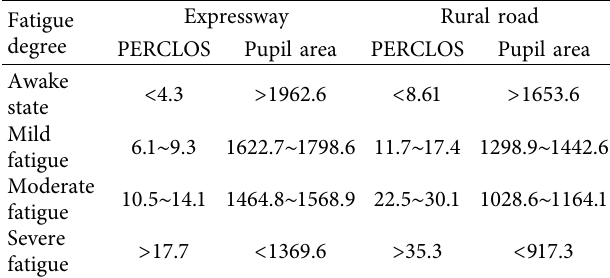
Table 4: Fatigue index grade.